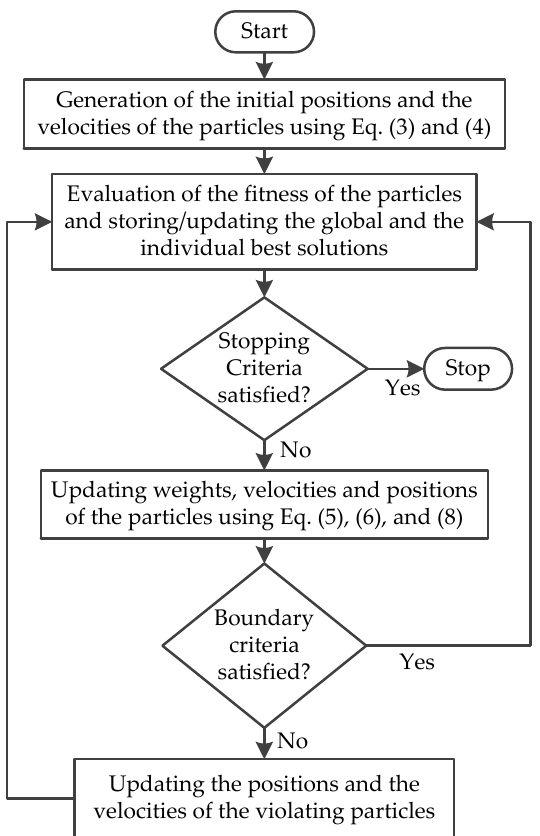
Figure 1. The flowchart of the constriction factor particle swarm optimization.